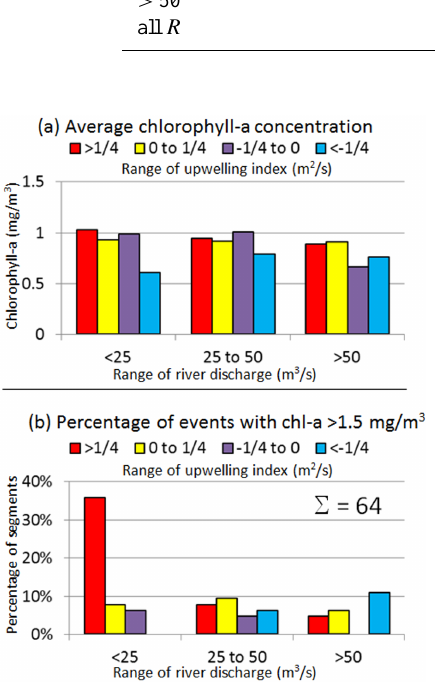
Figure 12. Event analysis of the time series (1 January 2005 to 31 March 2014). (a) Average chlorophyll a values based on data segments that fall into certain intervals of upwelling index and dis- charge from the Davey River. The total number of segments is 316. (b) Number of data segments of chlorophyll a concentration > 1.5mgm − 3 , grouped as in panel (a) . In total, 64 of the 316 data segments satisfy this